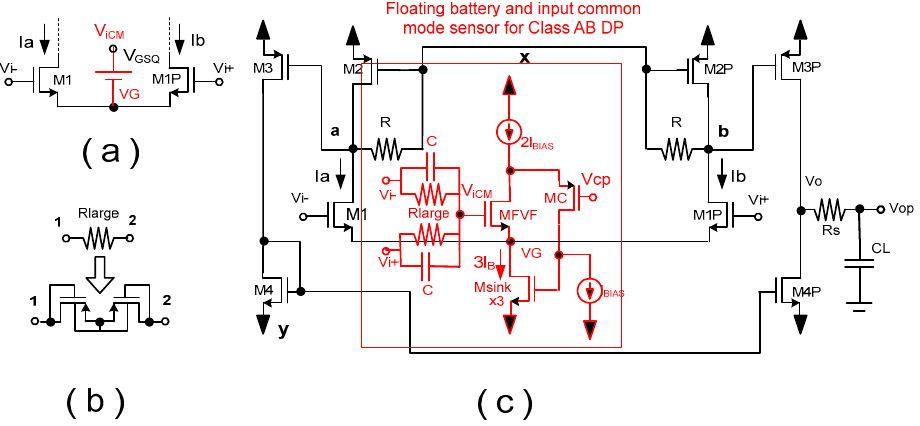
Figure 10. High gain super class AB OTA using the combined current boosting effect of RLCMFB and of class AB differential pair. ( a ) Conceptual implementation of class AB DP using the floating battery. ( b ) Implementation of very large resistive elements using quasi-floating gate transistors. ( c ) Transistor level implementation of super class AB OTA.